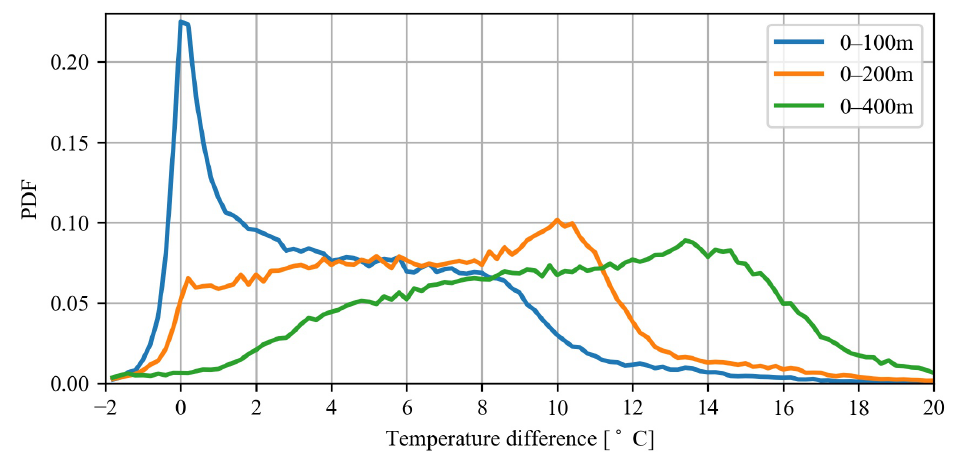
Figure 2. Probability density function (PDF) of temperature difference between the sea surface and at depth of 100 m, 200 m and 400 m, respectively.